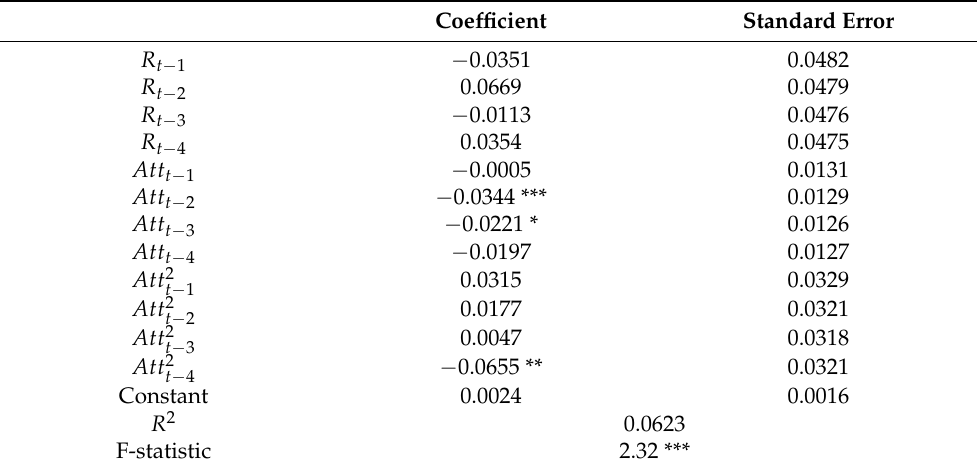
Table 4. Estimation results after controlling squared Bitcoin attention.